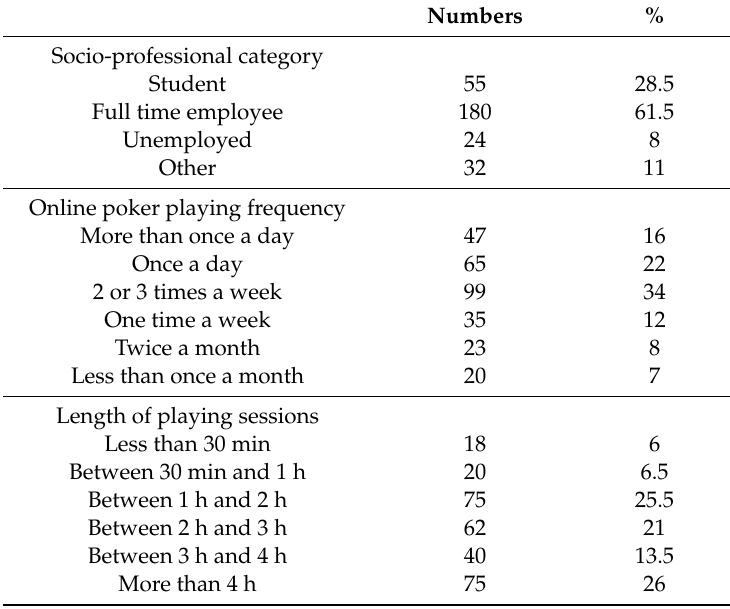
Table 1. Descriptive statistics of our sample of 291 online poker